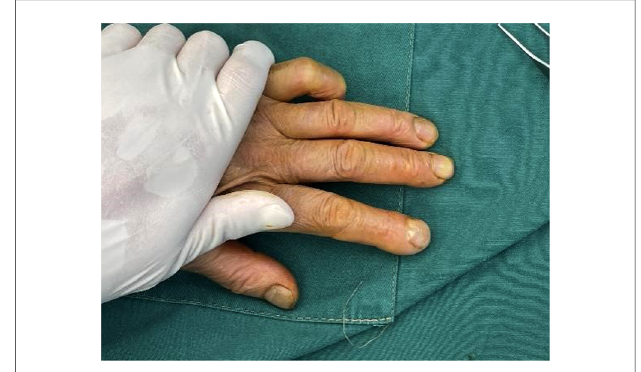
FIGURE 1 Preoperative view showing the swelling, redness, and tenderness on the eponychium of the left index fi nger.